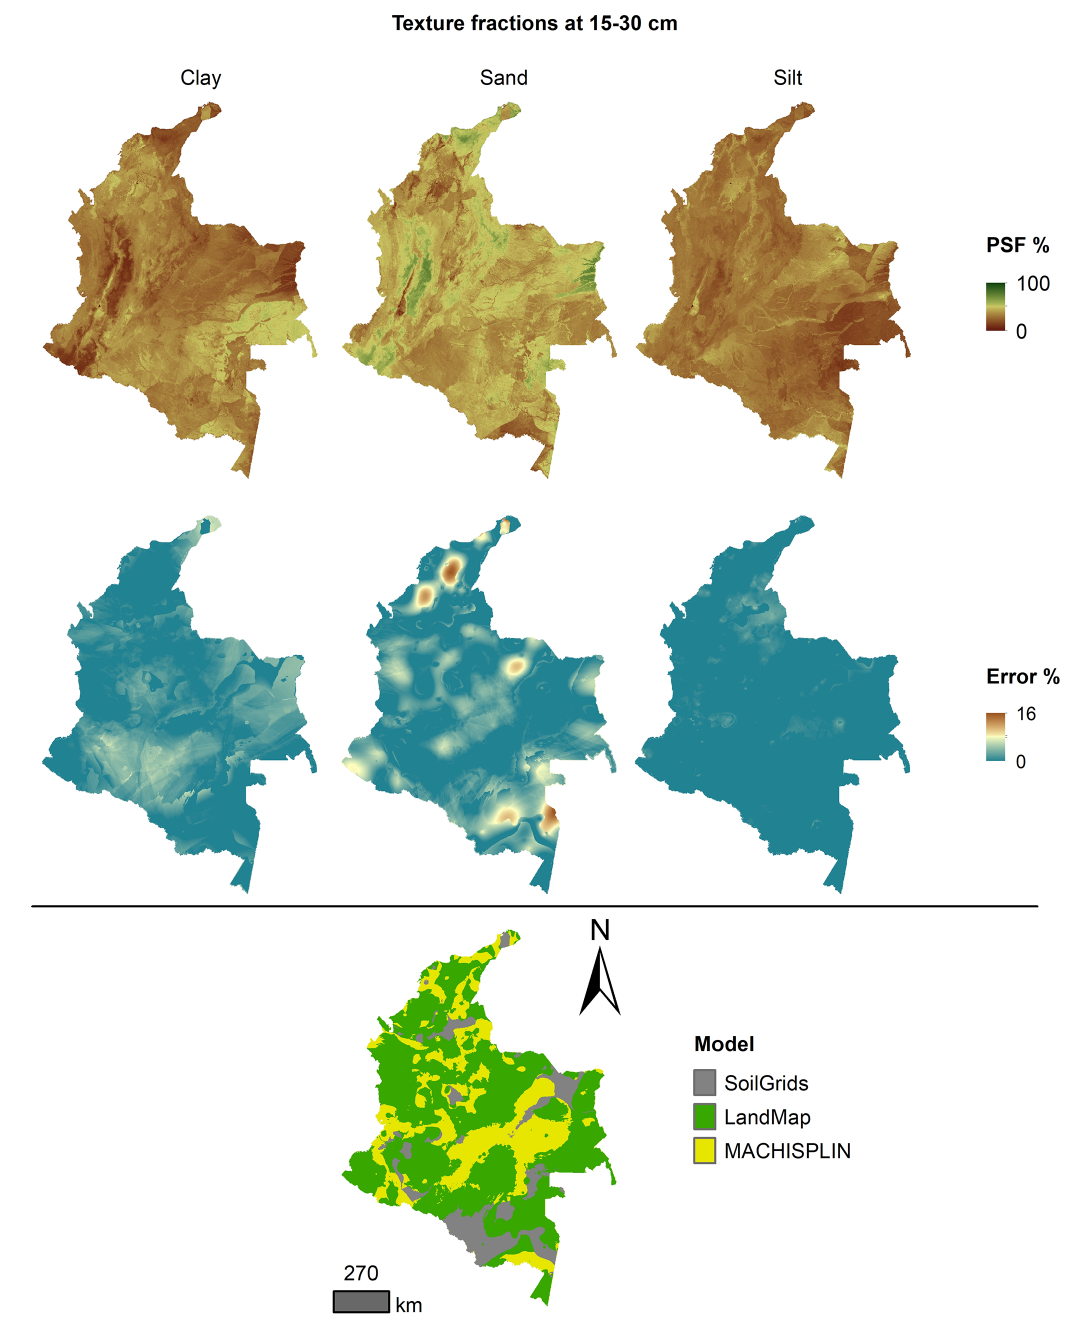
Figure 7. Ensemble model, percentage error distribution, and best model selected at